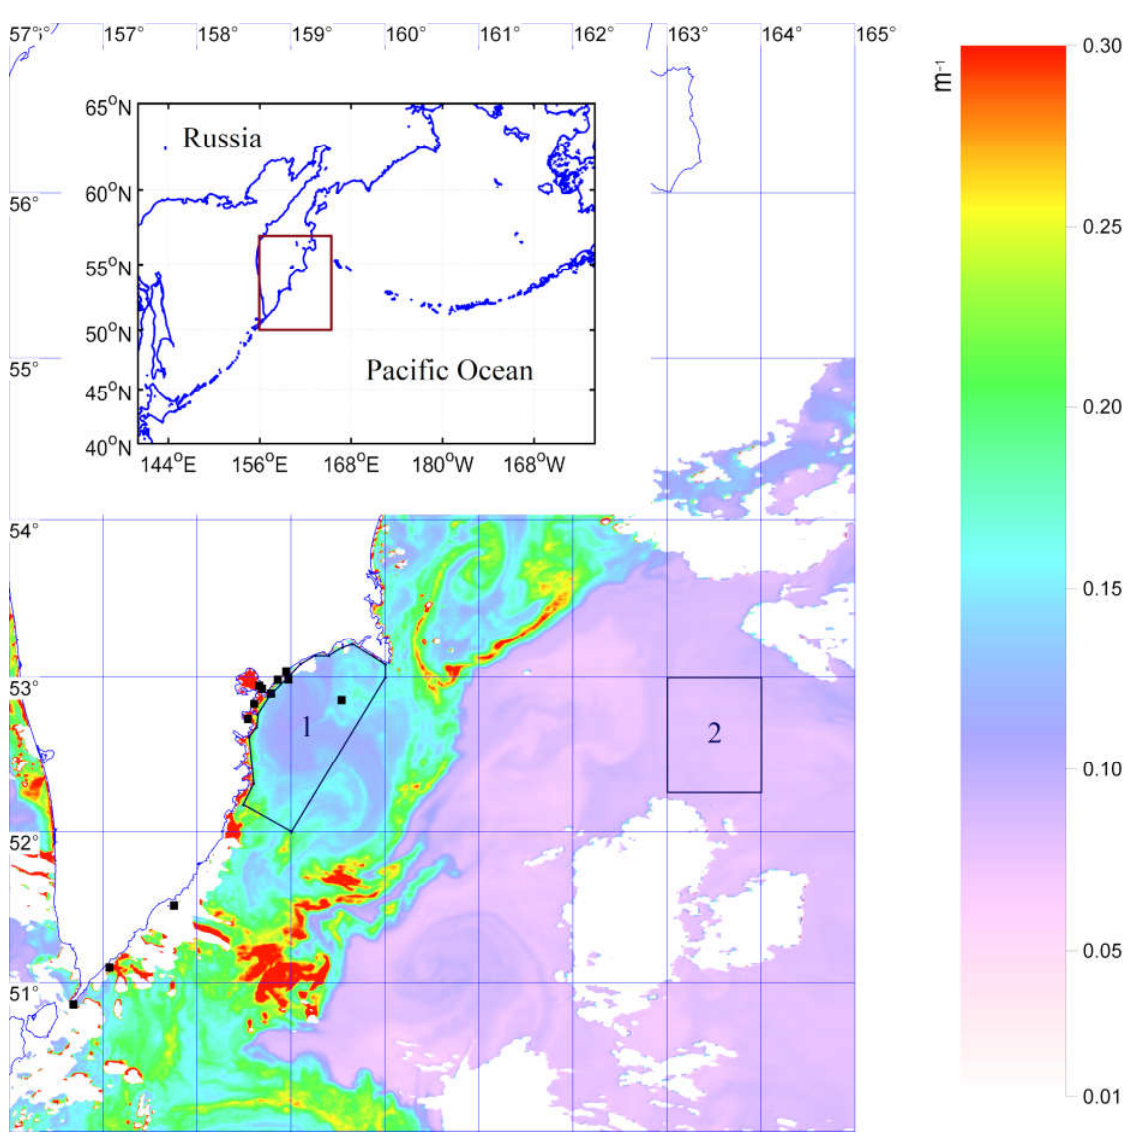
Figure 1. A characteristic of water turbidity— light attenuation coefficient (Kd490) MODIS/AQUA, Sept. 9. Boxes = zones for assessing the average values of bio-optical parameters for coastal (1) and open ocean waters (2); black dots = station locations. Here and later in the paper, pixels that are not related to the water surface are in white.